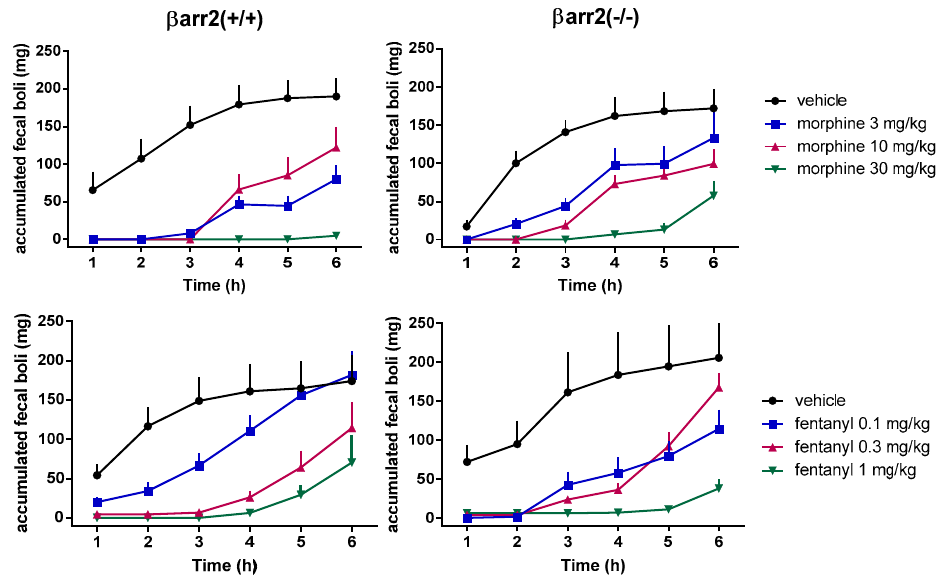
Figure 1. Mouse tail withdrawal assay. Dose response curves to morphine ( left panel) and fentanyl ( right panel) in β arr2(+/+) and β arr2( − / − ) mice. Data are mean ± SEM of 6 animals for each treatment. Experiments were performed as described in [32].